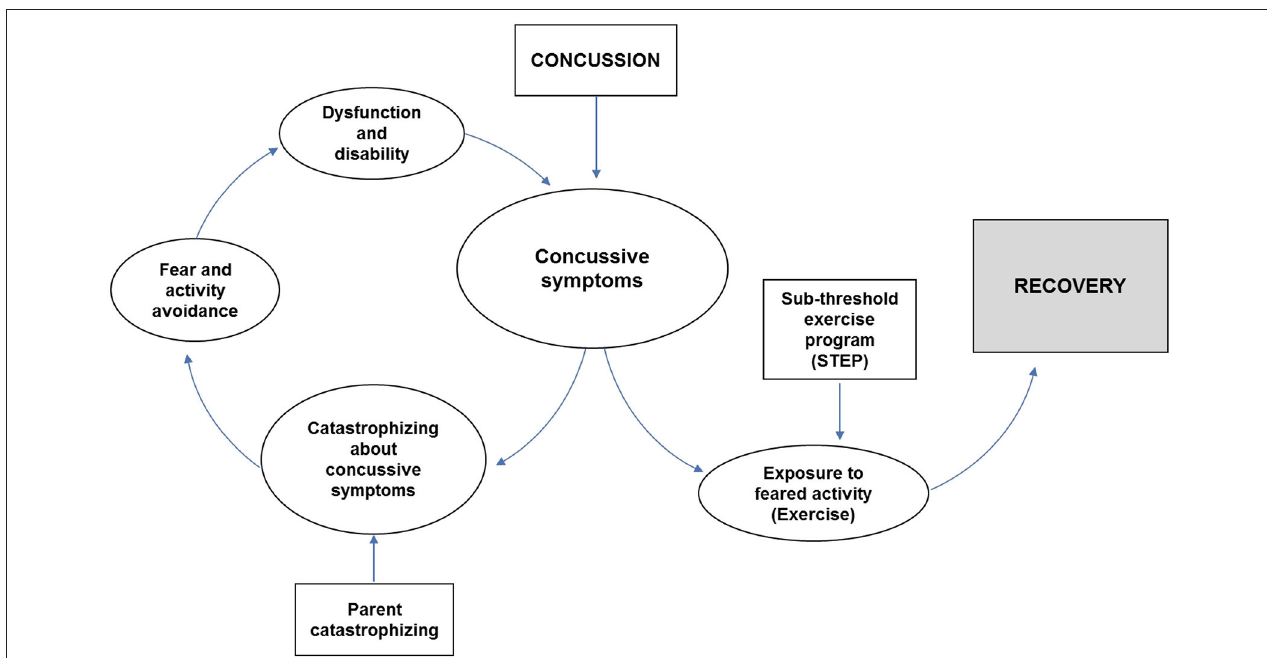
FIGURE 1 | Conceptual model of Fear-avoidance (19), adapted for